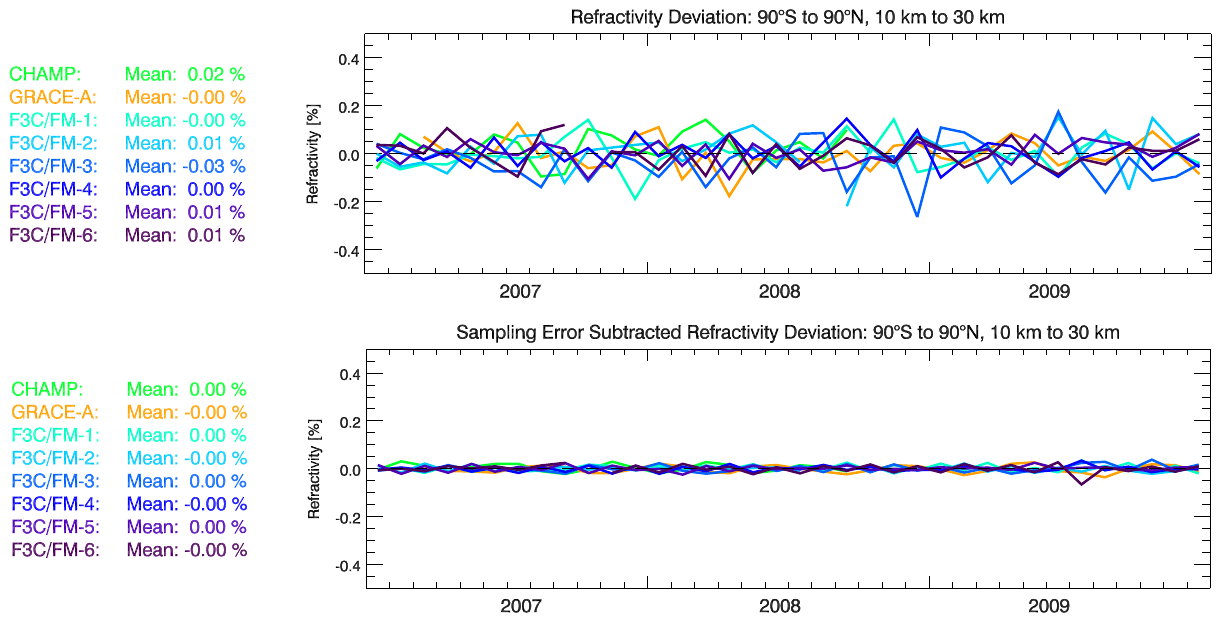
Fig. 4. Temporal evolution of global mean monthly mean single-satellite refractivity deviations from the multi-satellite mean (averaged over the entire domain from 10km to 30km altitude) from January 2007 to December 2009. Deviations with sampling errors included (top) and subtracted (bottom), respectively, are shown for eight satellites (listed left; showing also for each satellite the time-averaged mean value from its full period of